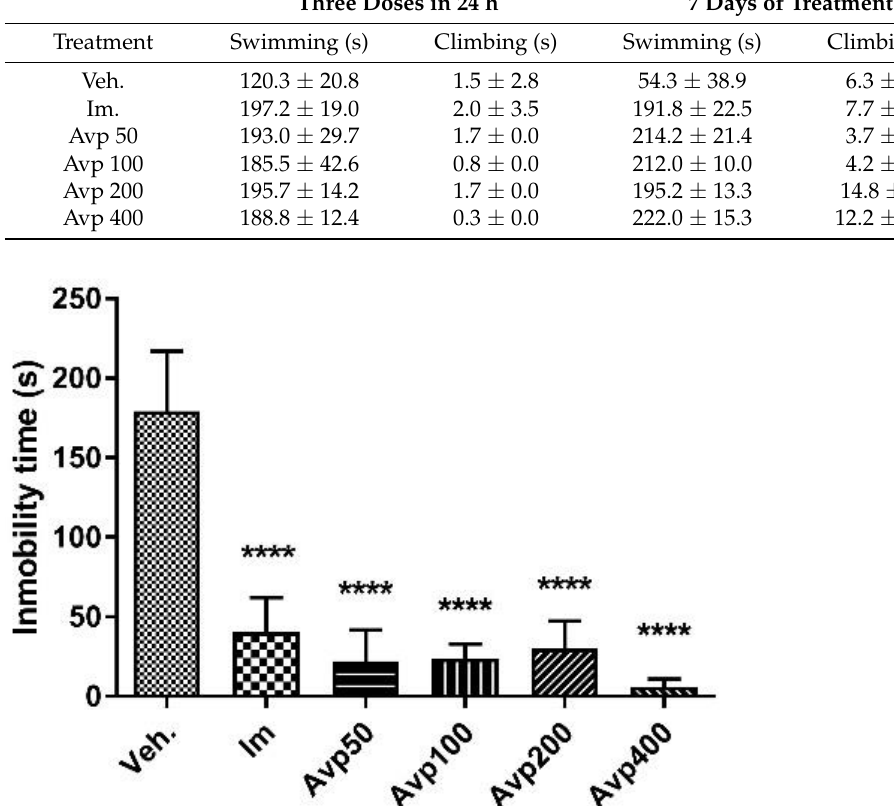
Table 2. Climbing and swimming behavior time of mice ( n = 6) after treatment with three doses in a 24-h period of Aloysia virgata var. platyphylla . Three Doses in 24 h 7 Days of Treatment Treatment Swimming (s)